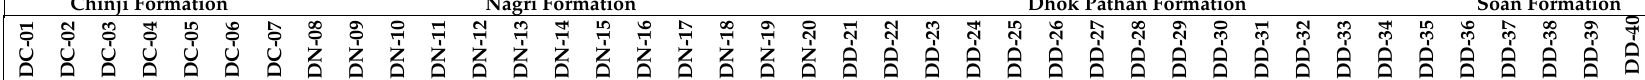
Table 2. Modal mineralogical compositions of Siwalik Group of core of